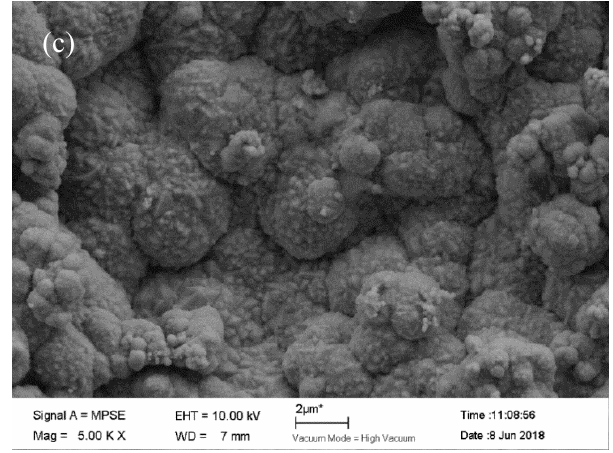
Figure 7. Micrographs of composite coatings prepared by different reverse working times (×5000): ( a ) 10 ms, ( b ) 13 ms, ( c ) 20 ms.